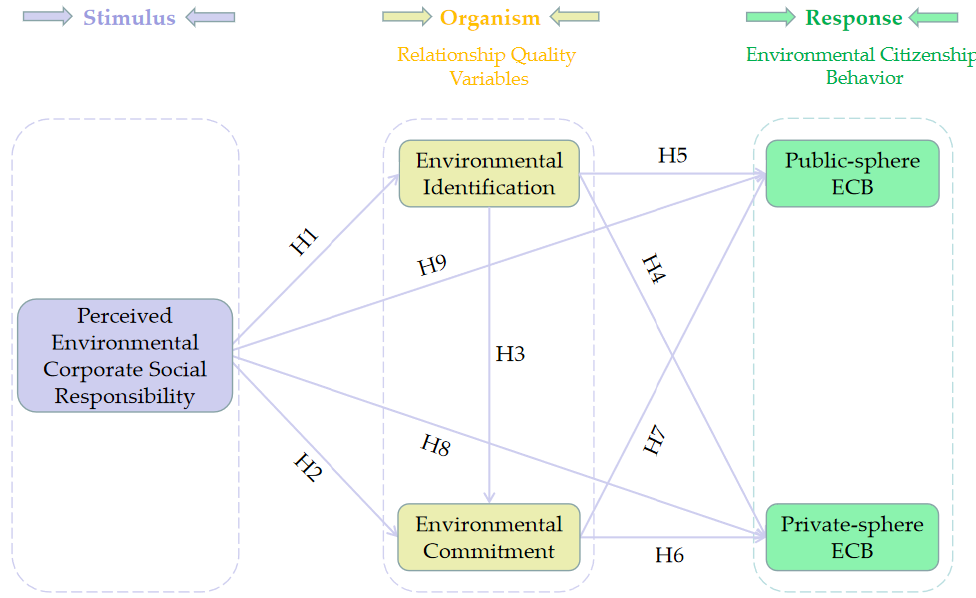
Figure 1. Conceptual framework of the present research.